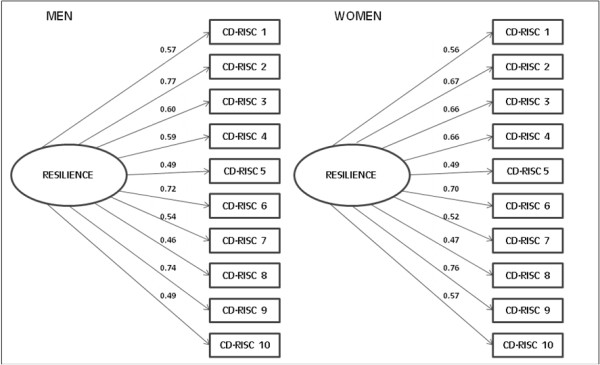
Factor loading and goodness-of-fit indexes for our single-factor model for the CD-RISC-10 factor structure, by sex. Men: n = 175; χ2 = 135.8, df = 35, p = 0.001, CFI = 0.82 and SRMR = 0.073. Women: n = 506; χ2 = 106.4, df = 35, p = 0.001, CFI = 0.95 and SRMR = 0.040.